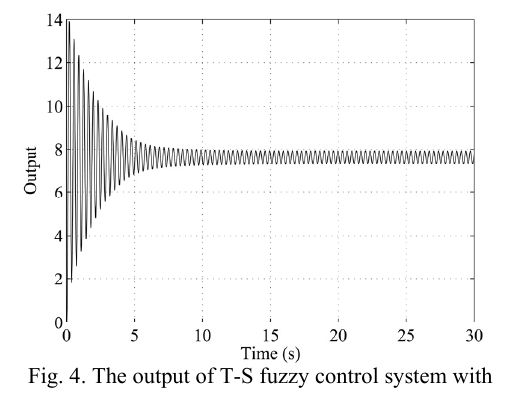
Fig. 4. The output of T-S fuzzy control system with reference